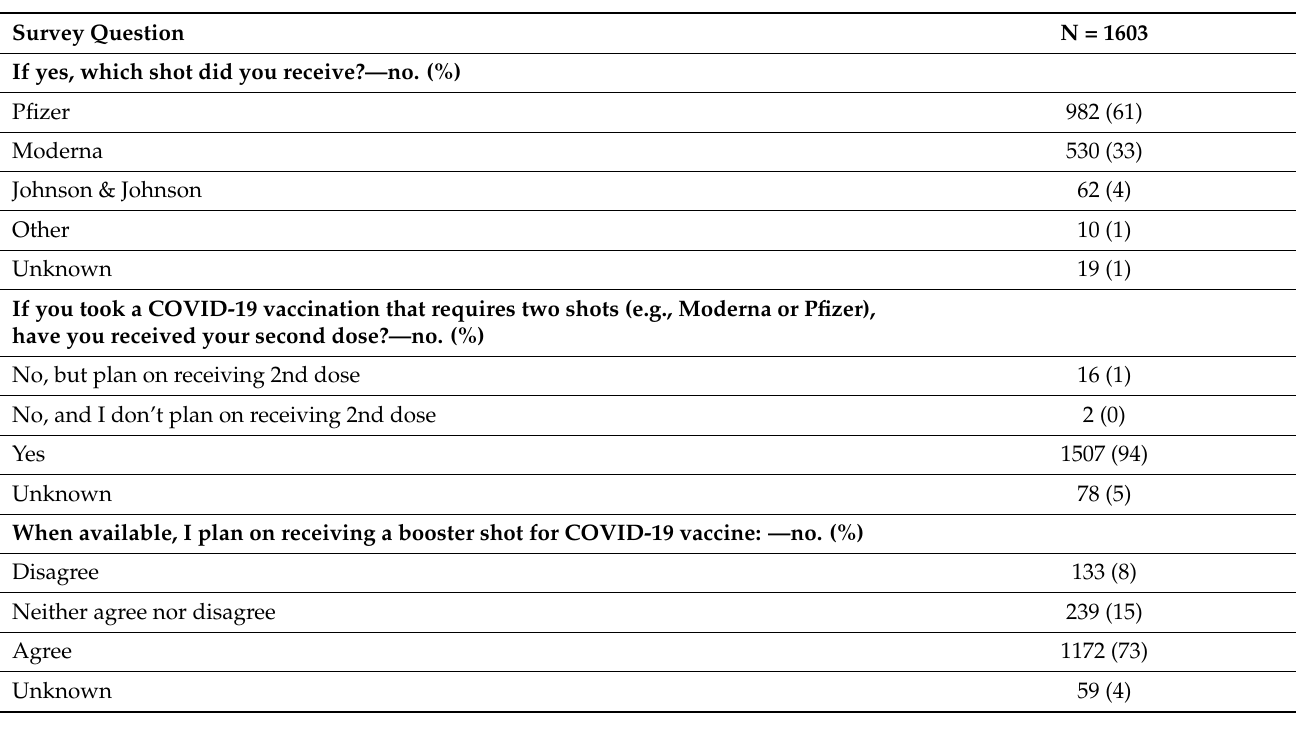
Table 2. COVID-19 vaccination among those who had at least one dose of a COVID-19 vaccine.